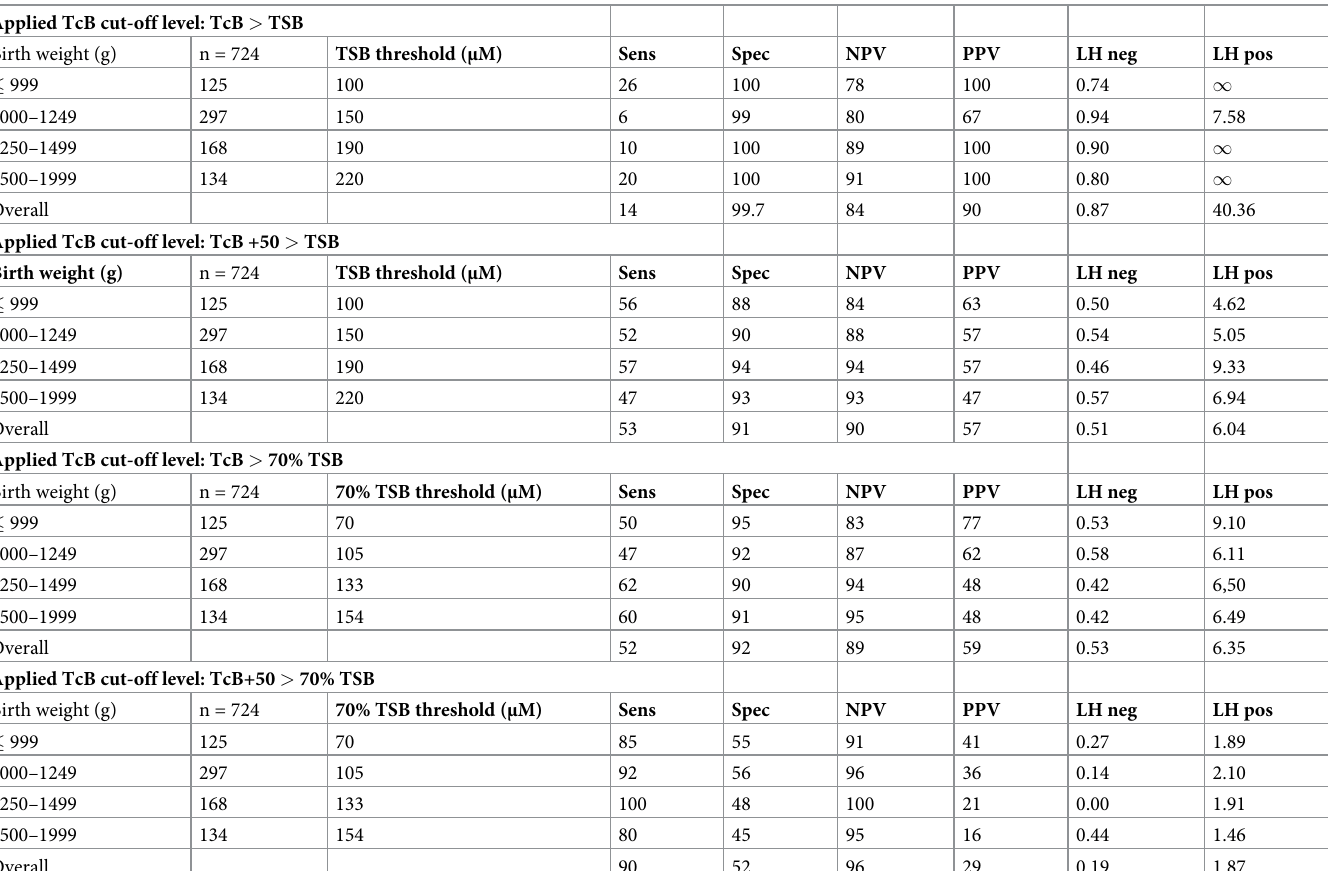
Table 3. Accuracy parameters of different TCB cut-off